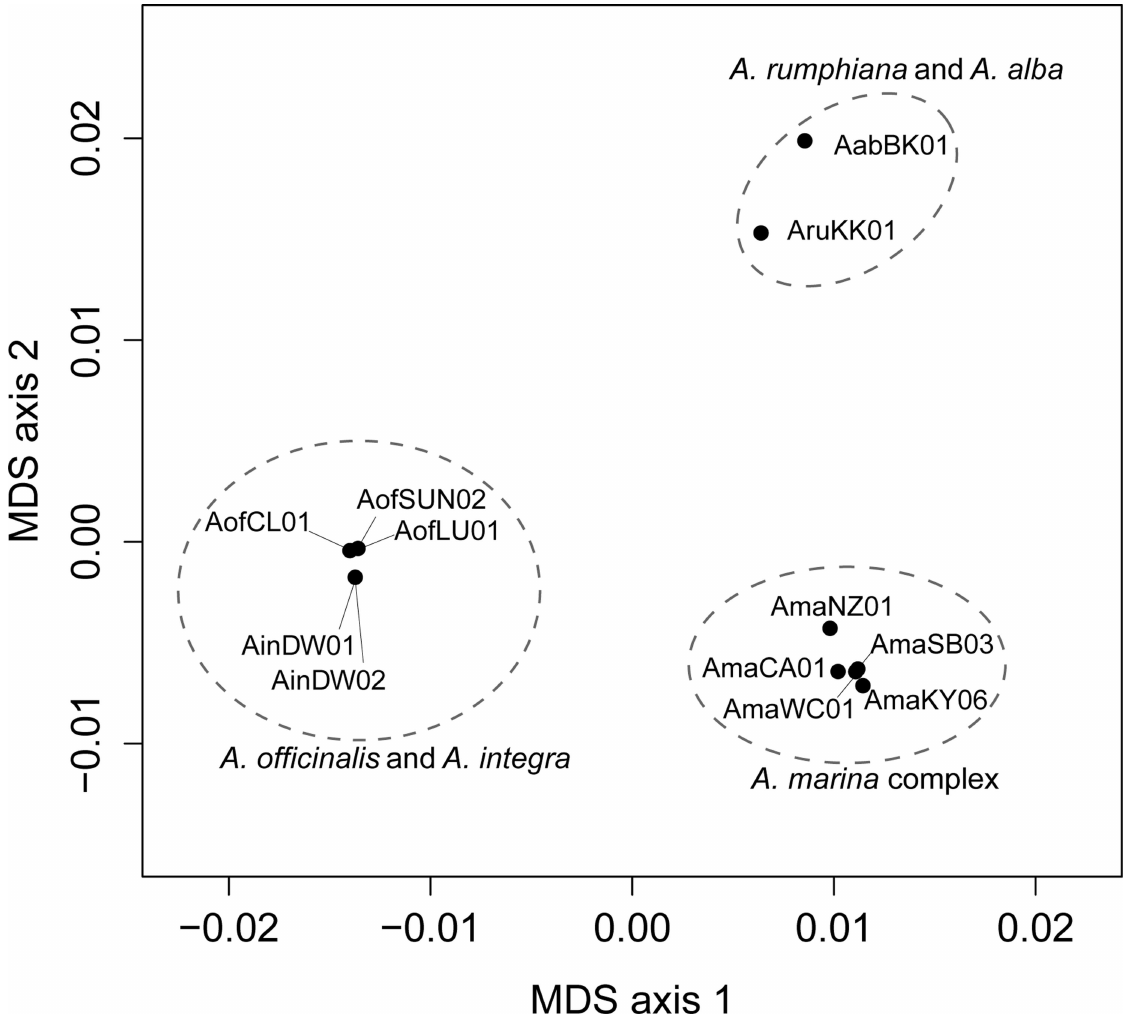
Fig 3. Multidimensional scaling plot. Plot of the first and second axis of a multidimensional scaling matrix based on pairwise genetic divergence value among IWP species of 25 nuclear genes. The numbers and letters refer to sample identity is listed in Table